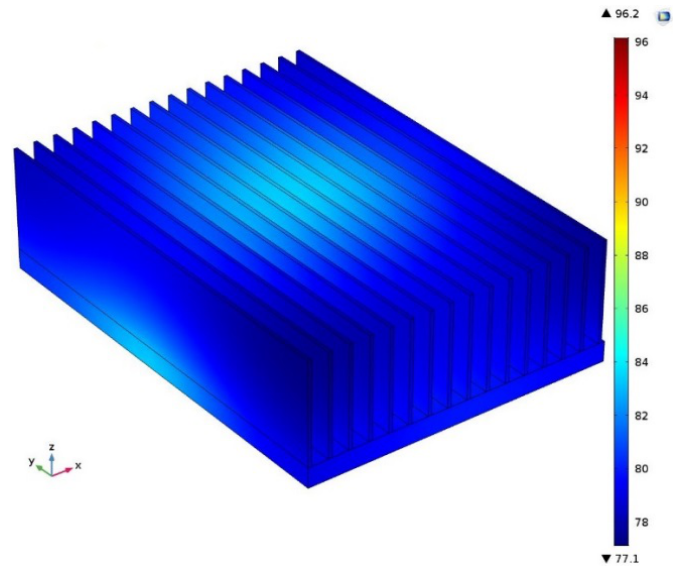
Figure 23. Temperature profile of Si model with heatsink visible.